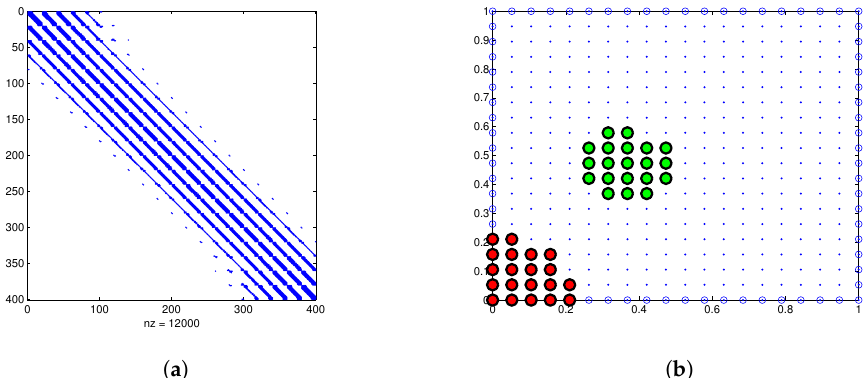
Figure 1. ( a ) Sparsity of matrix W , when ns = 30 and M = 400, and ( b ) centre distribution in domain [ 0,1 ] 2 corresponding to Example 1.